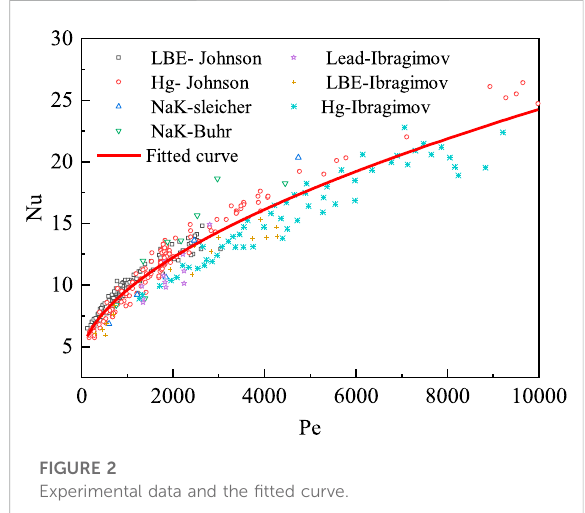
FIGURE 2 Experimental data and the fi tted